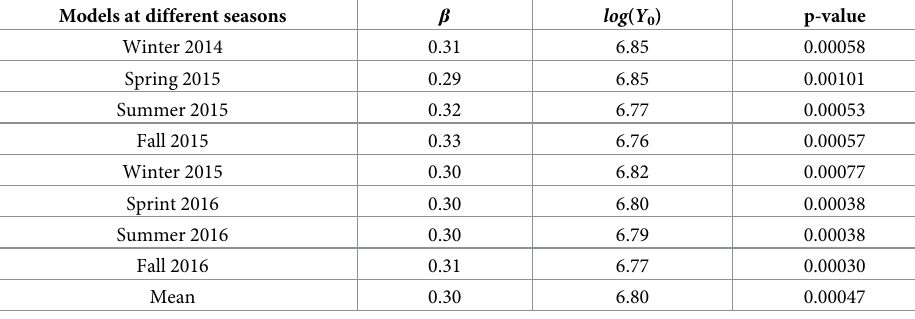
Table 1. Coefficients and p-values of basic scaling relationship